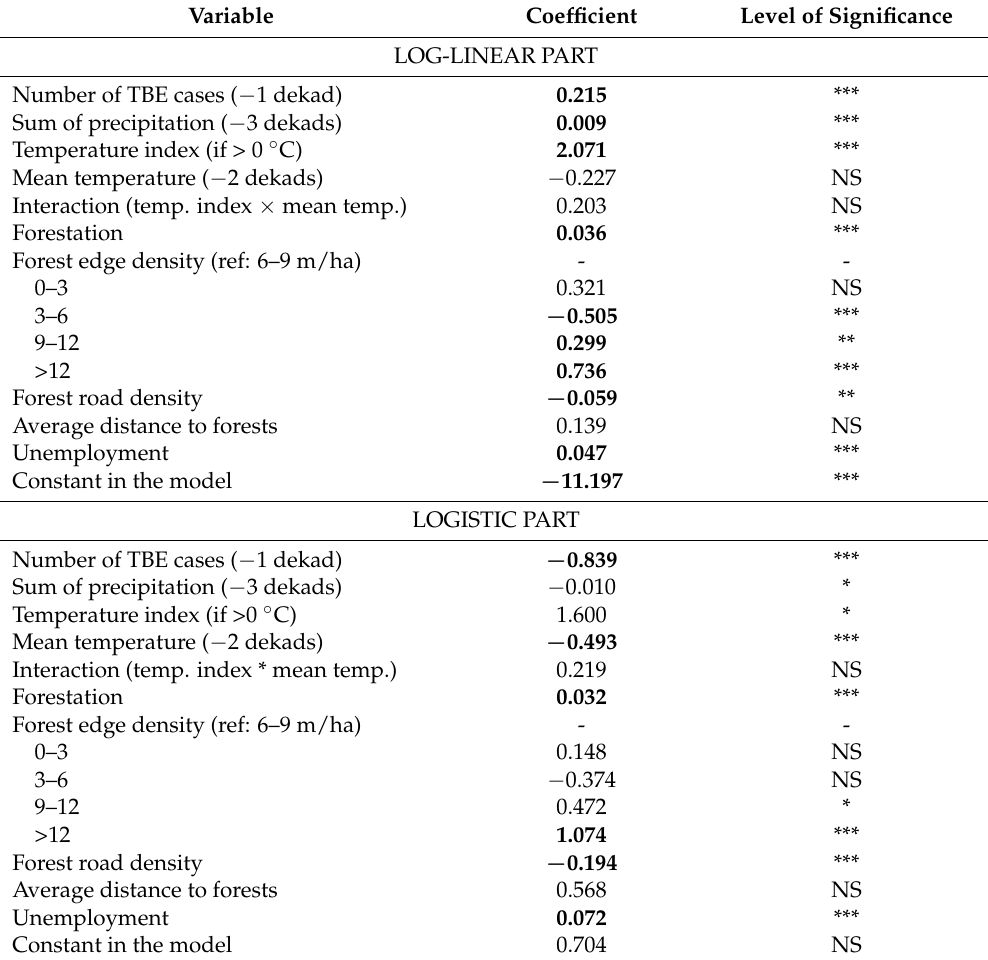
Table 2. Final model assessing the associations between determinants of TBE endemicity with the TBE occurrence, 108 endemic municipalities,